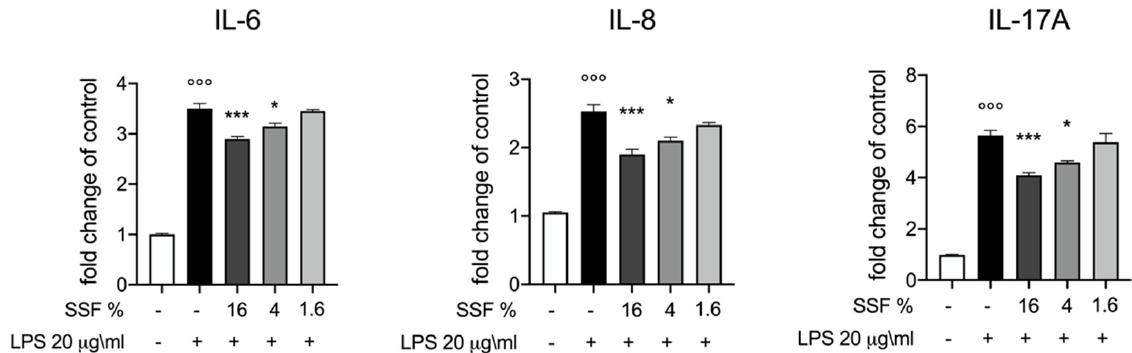
Figure 2. Effect of SSF on IL-6, IL-8 and IL-17A expression. ELISA quantification of IL-6, IL 8, IL-17A after LPS intoxication and lSSF treatment. SSF was efficient at notably reducing IL-6, IL 8, IL-17A. Data representative of at least three experiments, ◦◦◦ p < 0.001 versus CTR; * p < 0.05 versus LPS; *** p < 0.001 versus LPS.